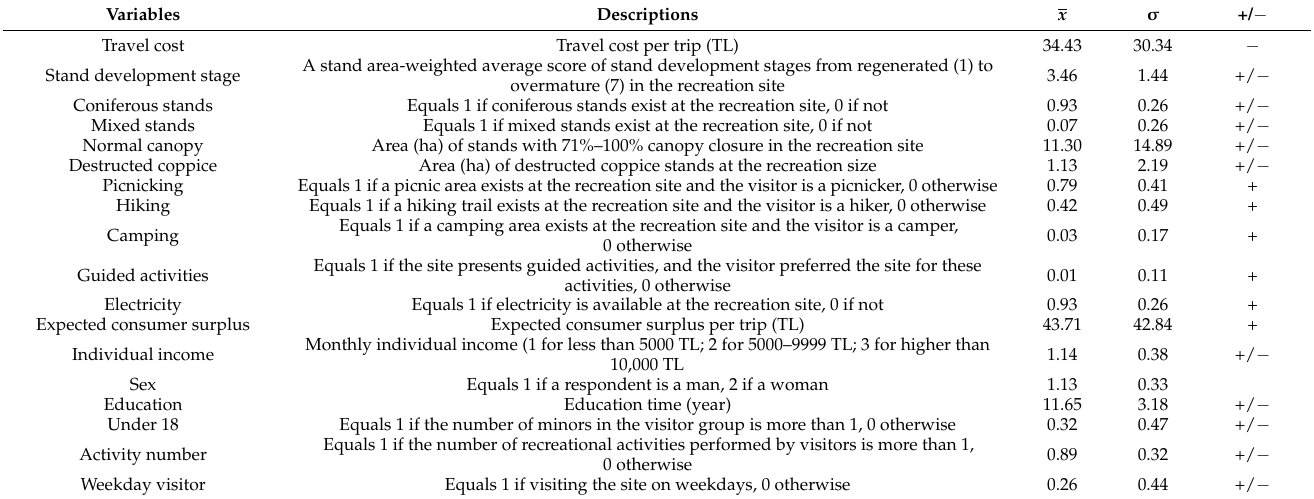
Table 1. Definitions, descriptive statistics, and expected signs of variables in the